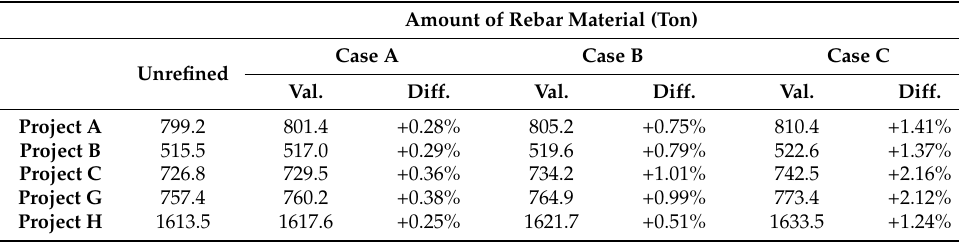
Table 7. Amounts of Rebar Materials for Slab Members and Differentials by Cases.